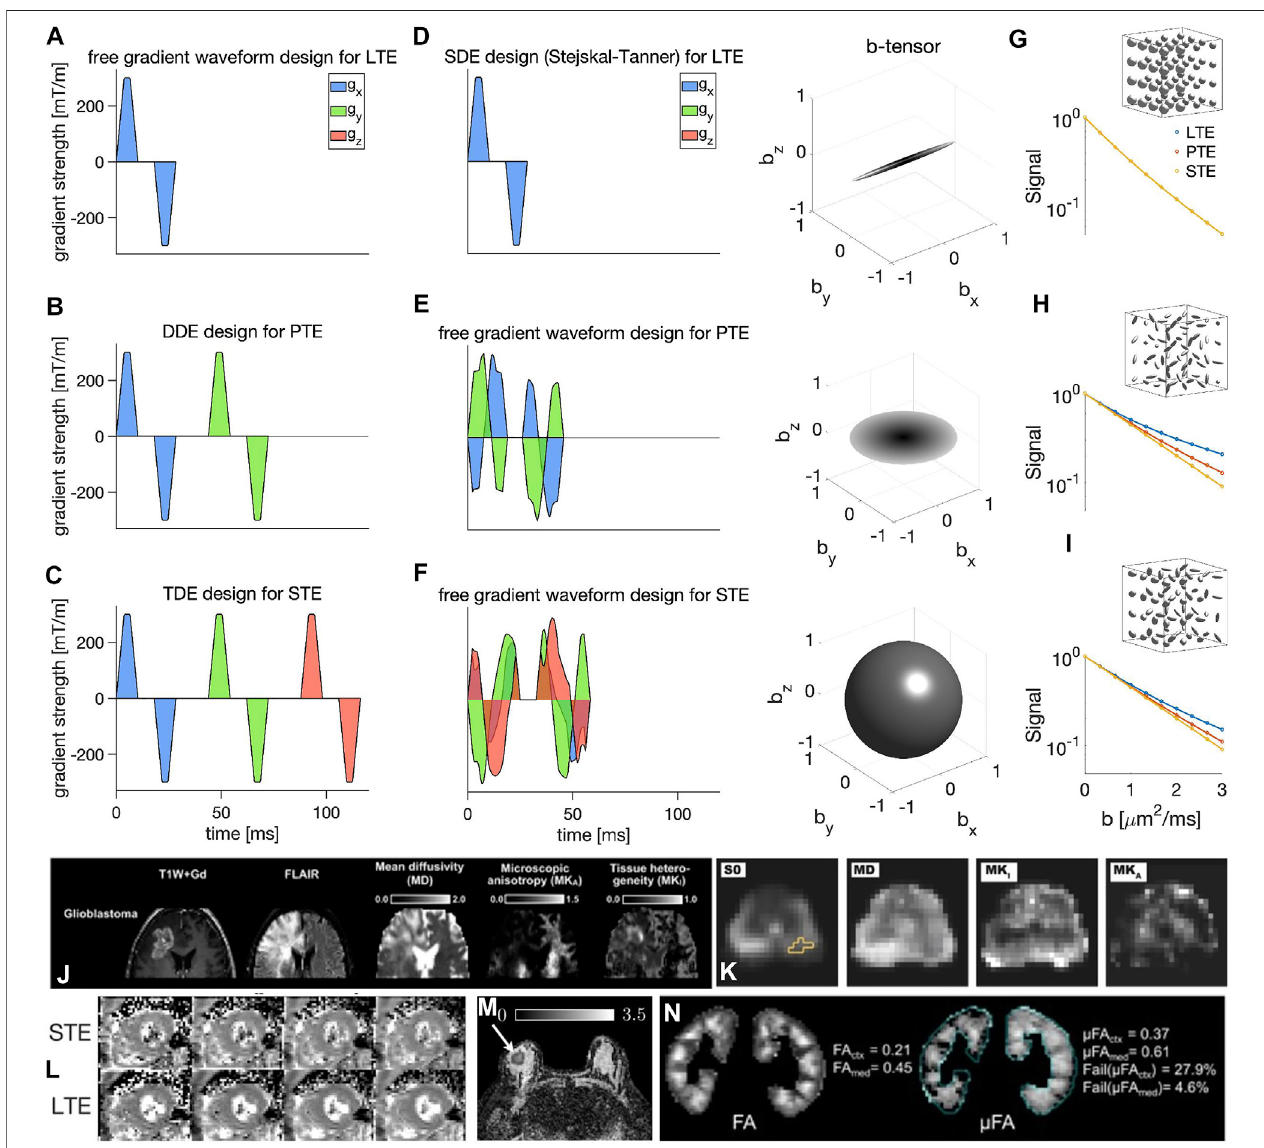
FIGURE 1 | Illustration of various diffusion encoding schemes (A – F) (all waveforms are effective). In each row, an exemplary diffusion weighting gradient waveform is shown on the left (x, y, and z components are shown in blue, green, and red, respectively) and its corresponding b-tensor shape is shown on the right. The diffusion encoding schemes shown here include: (A) SDE design by Stejskal and Tanner [38] for LTE, (B) DDE [48] design for PTE, (C) TDE [71] design for isotropic/spherical diffusionencoding, (D – F) freegradientwaveformencoding[86,87], (D) ,LTE, (E) PTE,and (F) STE.Sub fi gures (G – I) showtheplotsoftheMRsignalversusb-value measured in three synthetic environments; (G) fast and slow isotropic compartments, (H) randomly oriented anisotropic compartments, and (I) randomly oriented anisotropic compartments with different anisotropies using linear, planar, and spherical b-tensors (the microenvironments are all assumed Gaussian components